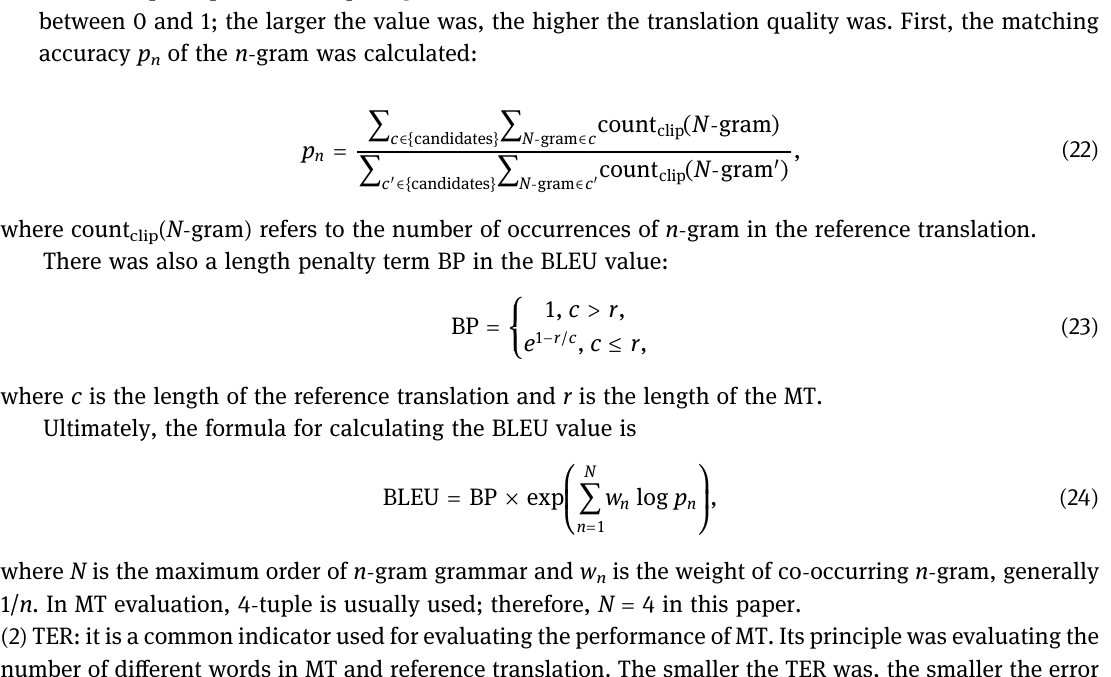
Table 1: Experimental data Chinese sentences English sentences